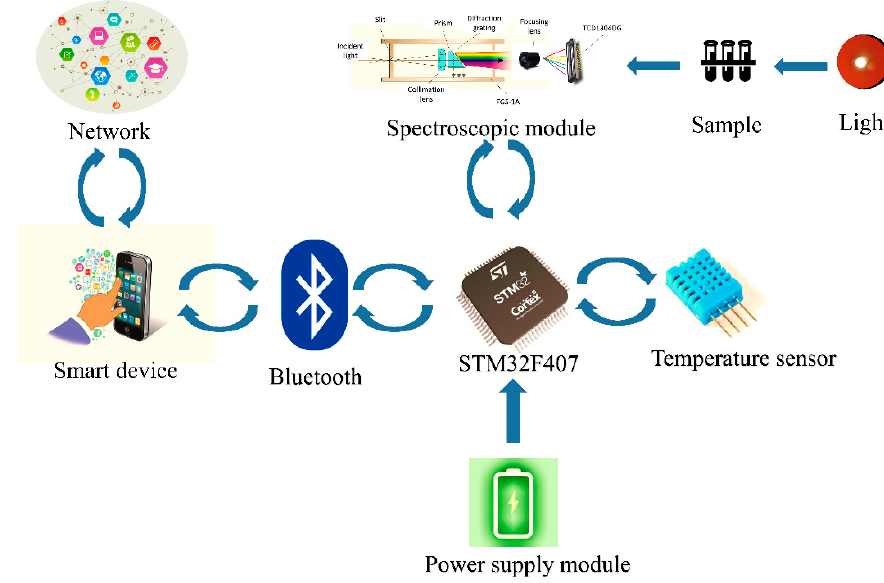
Figure 2. Structure of the portable smart spectrometer.